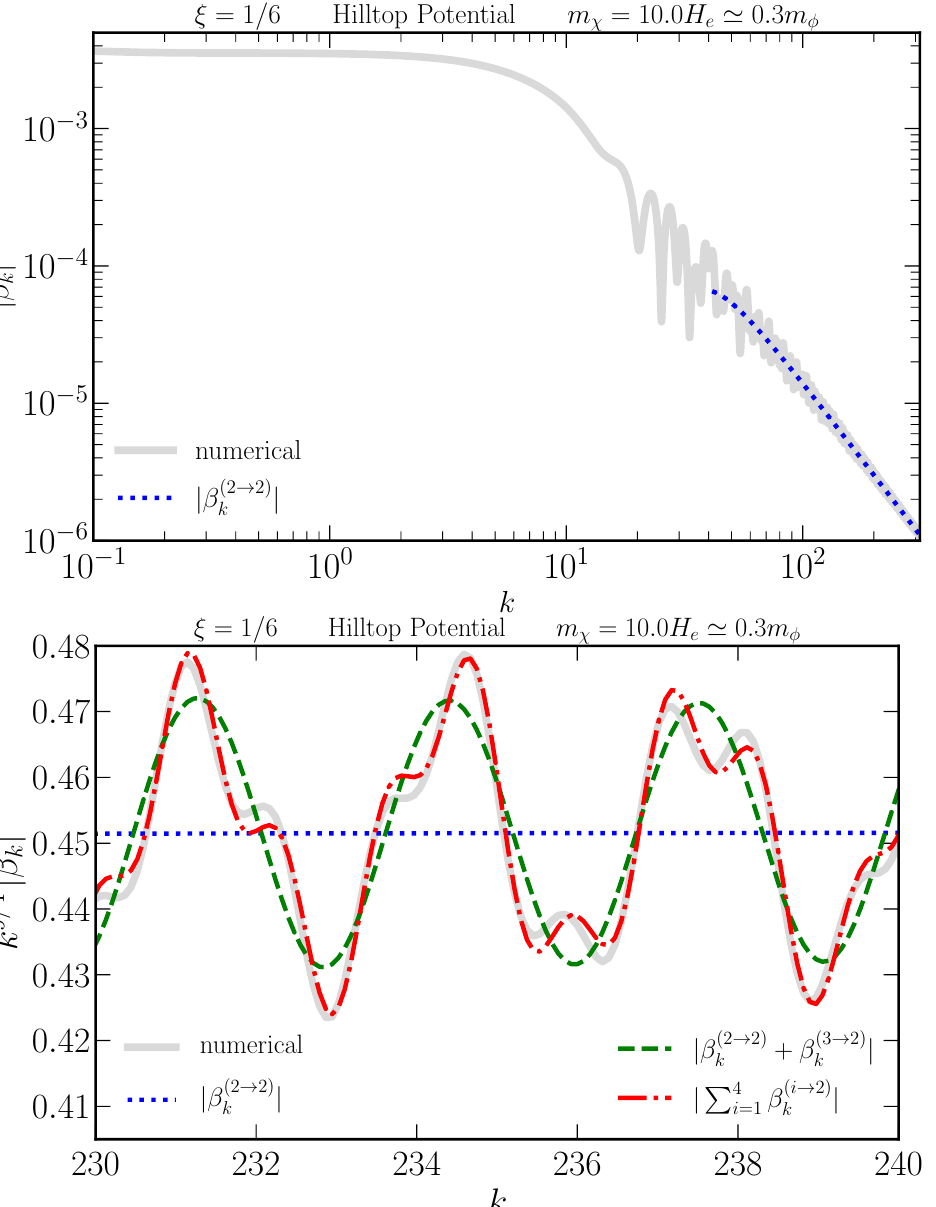
Figure 2 . Same as figure 1 but for the Hilltop Potential model and a different value of m χ . Note the more pronounced and irregular oscillatory behavior, which is explained in this work as result of interference among four components: β (1 → 2)